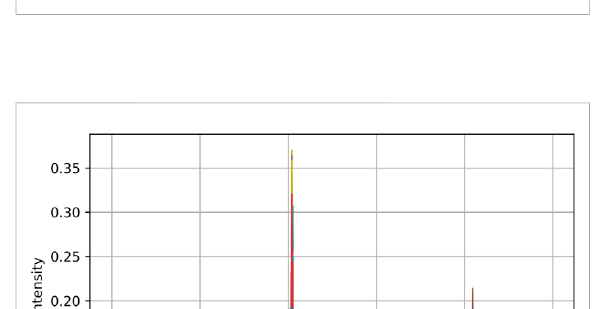
FIGURE 4 XRD raw data with normalized total intensities. Due to disturbedcellparameters,structuresofthesamecrystalclasshave slightly shifted characteristic peaks, which is dif fi cult for a clustering algorithm to detect.